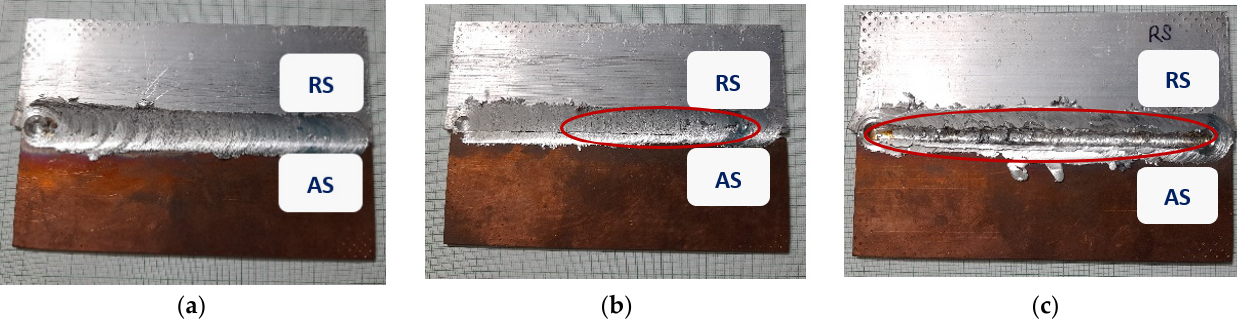
Figure 10. Surface morphologies of welded joints at tool offsets of ( a ) 2 mm, ( b ) 1.5 mm, and ( c ) 1 mm at a rotational speed of 1400 RPM and welding speed of 65 mm/min.